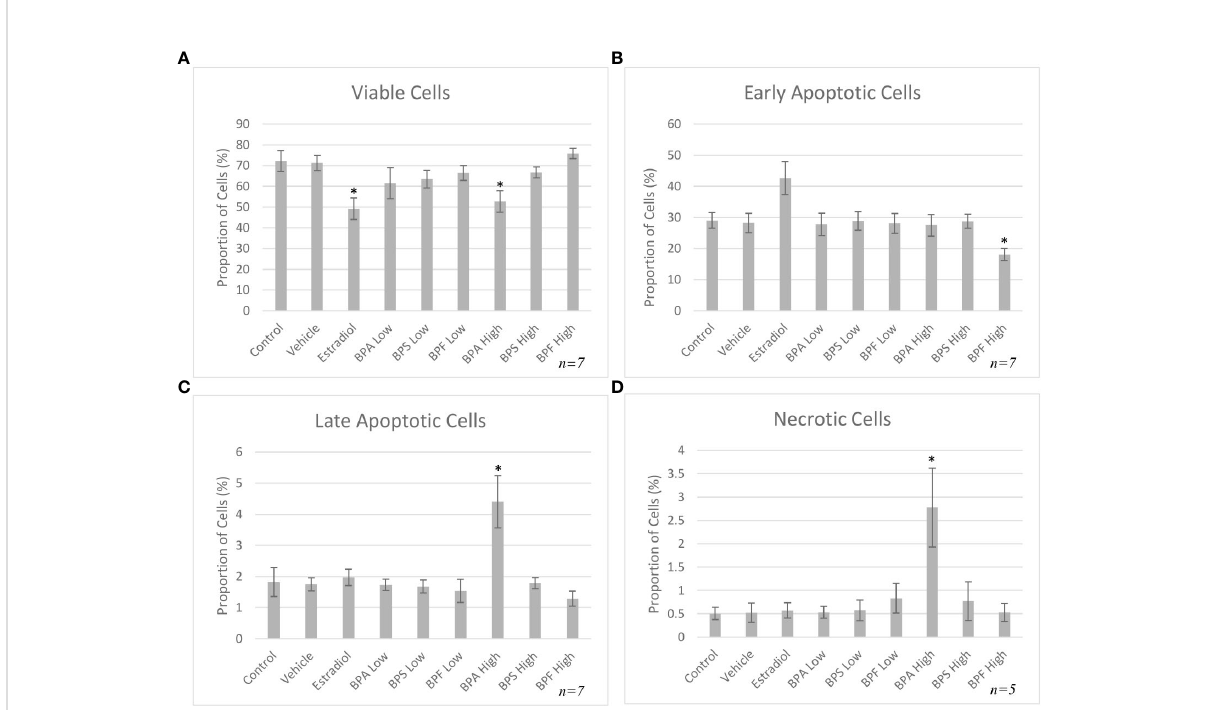
FIGURE 3 Apoptosis rates of bovine granulosa cells at 12 hours. This was detected by Annexin V-FITC/PI staining and fl ow cytometry. Columns represent the proportion (A) viable cells, (B) early apoptotic cells, (C) late apoptotic cells and (D) necrotic cells following treatment with BPA, BPS and BPF at two different concentrations for 12 hours. *p<0.05 compared to controls was considered as statistically signi fi cant. Error bars represent +/-